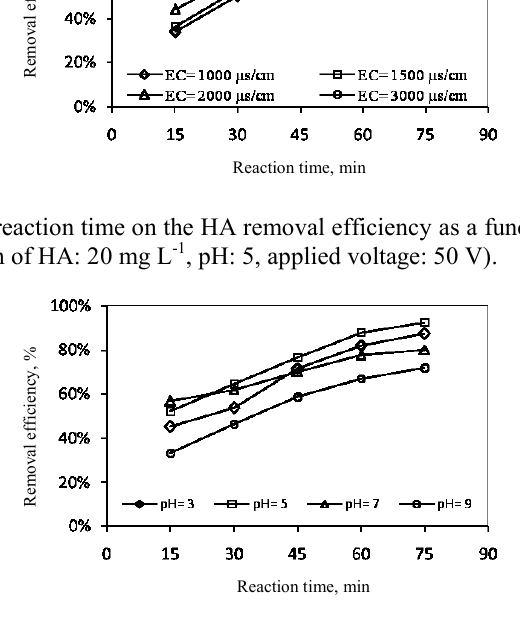
Figure 7. Effect of reaction time on the HA removal efficiency as a function of pH (initial concentration of HA: 20 mg L -1 , conductivity: 3000 µS/cm, applied voltage: 50